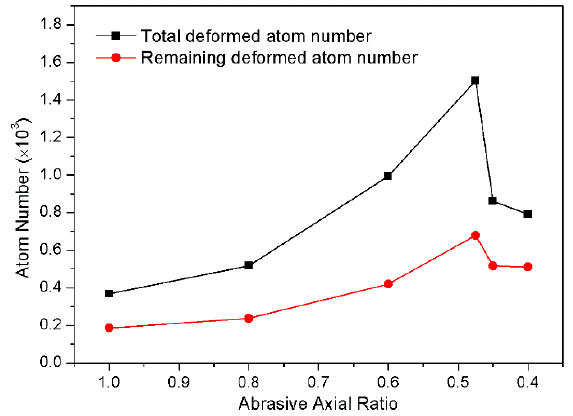
Figure 10. Atom number of the total transformational atoms during the moving process of particles and the remaining transformational atoms in the scratched region.